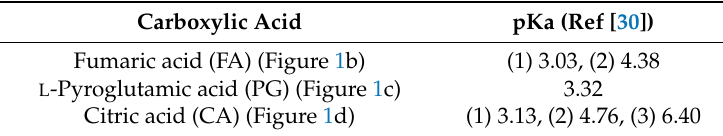
Table 1. pKa values of carboxylic acids employed for the screening of Mirabegron (MBR) co-amorphous (MBR pKa 8).